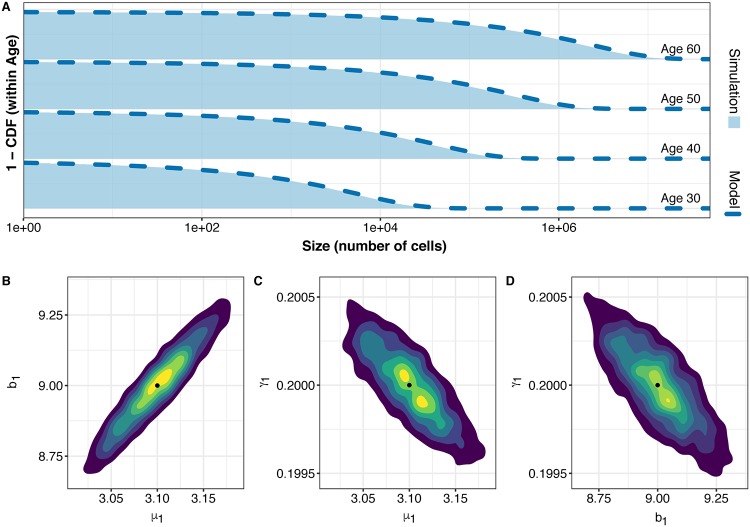
Agreement of simulation and mathematical model for compartment A.(A) Comparison of 1-CDF(number of cells) (percent of simulations with more than N cells at a given age) for the 100,000 simulations and the model prediction for the same parameters. Dashed dark blue line: model prediction using simulated parameters. Light blue area: empirical probability of observing more than N cells at a given age for the simulated parameters (μ1 = 3.1, b1 = 9, d1 = 8.8, μ2 = 10−5, b2 = 9.2, and d2 = 8.8). (B-D) Empirical MCMC-derived 2D density of posterior distribution of parameters. Warmer color indicate parameter values which are more likely to have produced the data. Black dots indicate the simulated parameter values: μ1 = 3.1, b1 = 9, and γ1 = .2